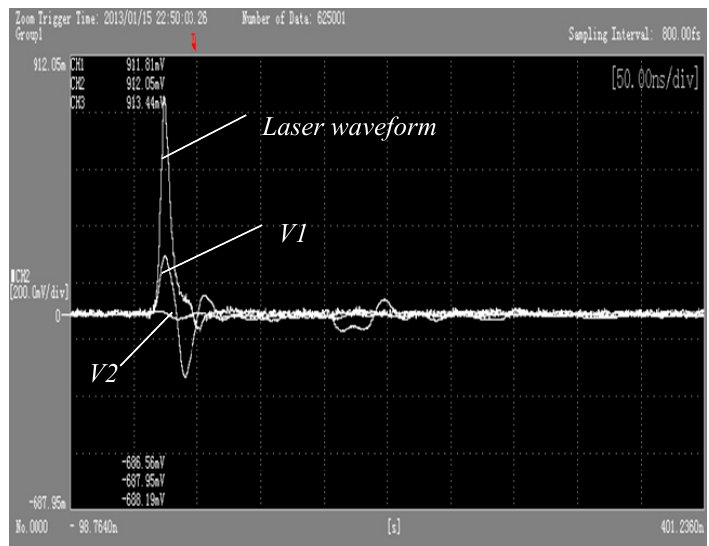
Figure 10. Piezoelectric signal curve when the wavelength is 1064 nm and laser power density is 6.3 GW/cm 2 on the target surface.